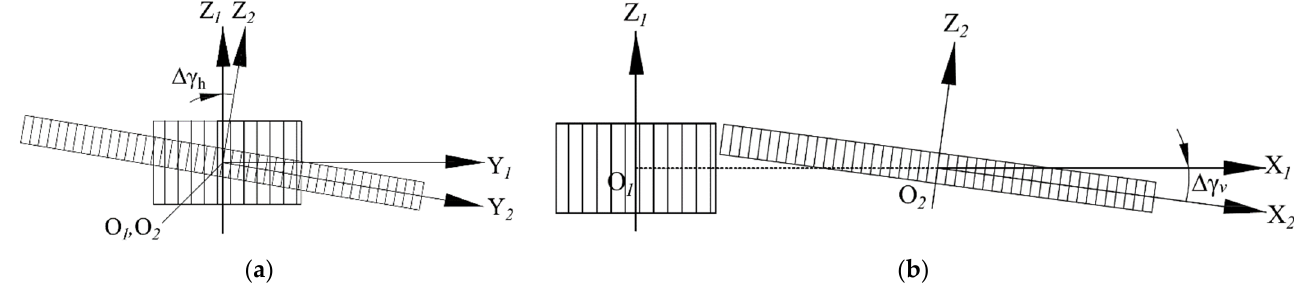
Figure 3. Illustration of assembly errors: ( a ) horizontal axial misalignment; ( b ) vertical axial misalignment.